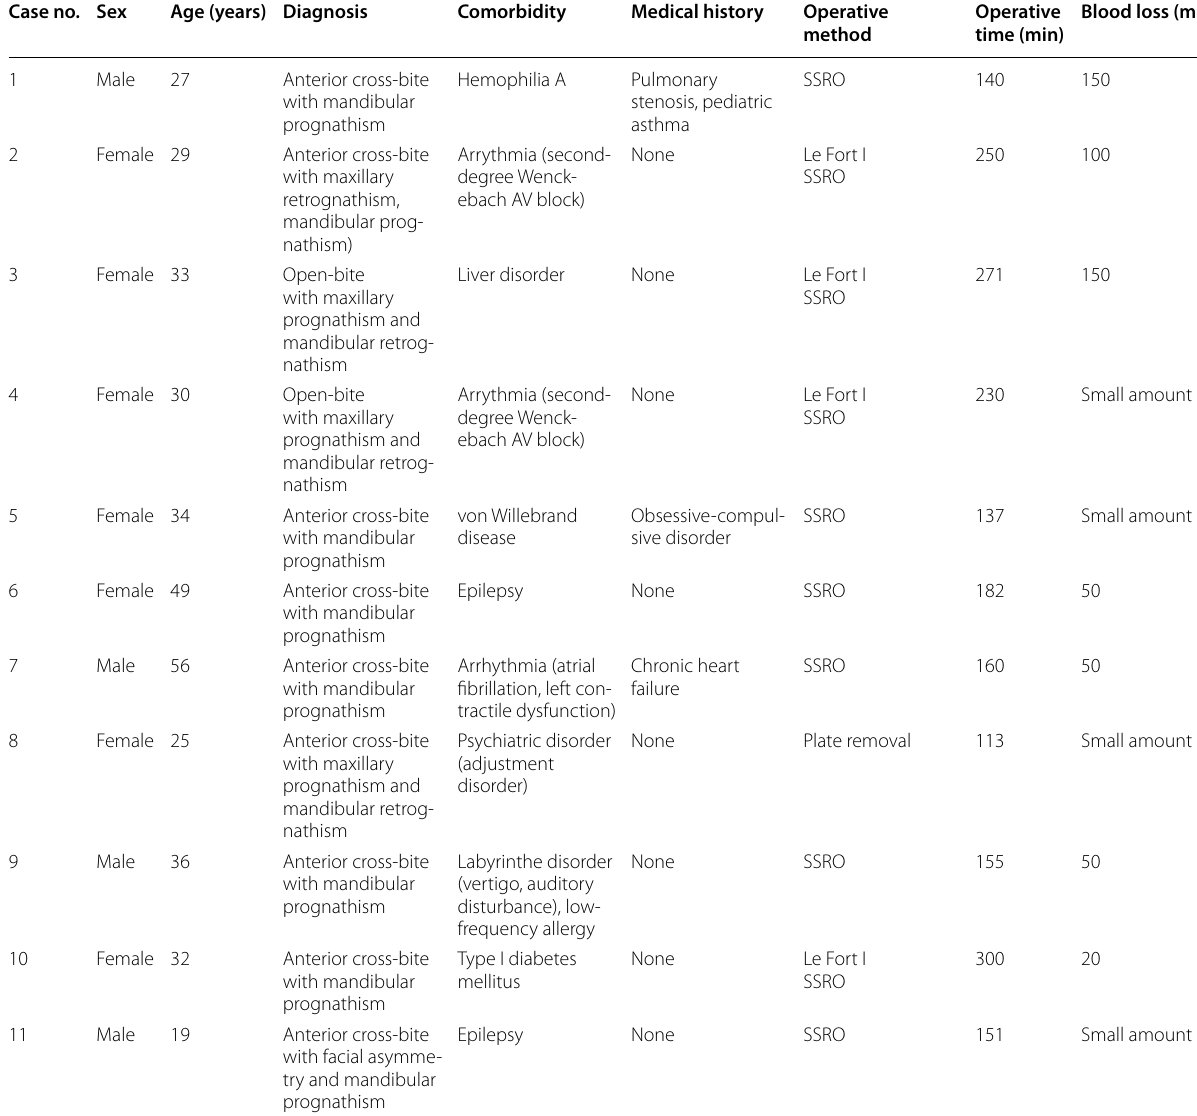
SSRO sagittal split ramus osteotomy, AV atrioventricular